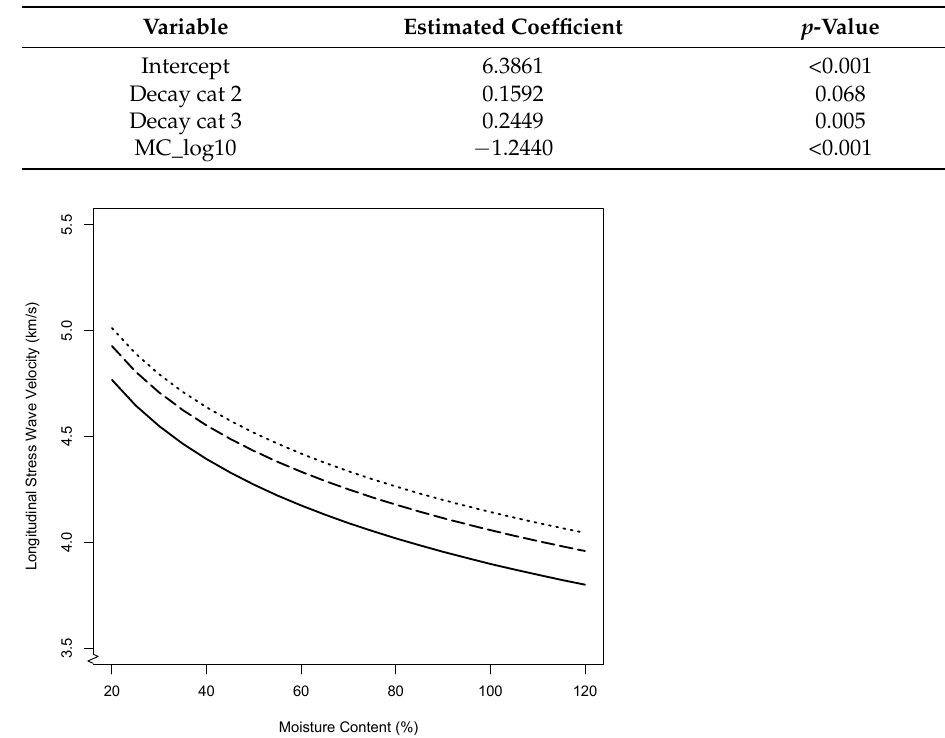
Table 2. Coefficients and p -values of a general linear model to test relationships between decay category, moisture content, and stand average velocity.